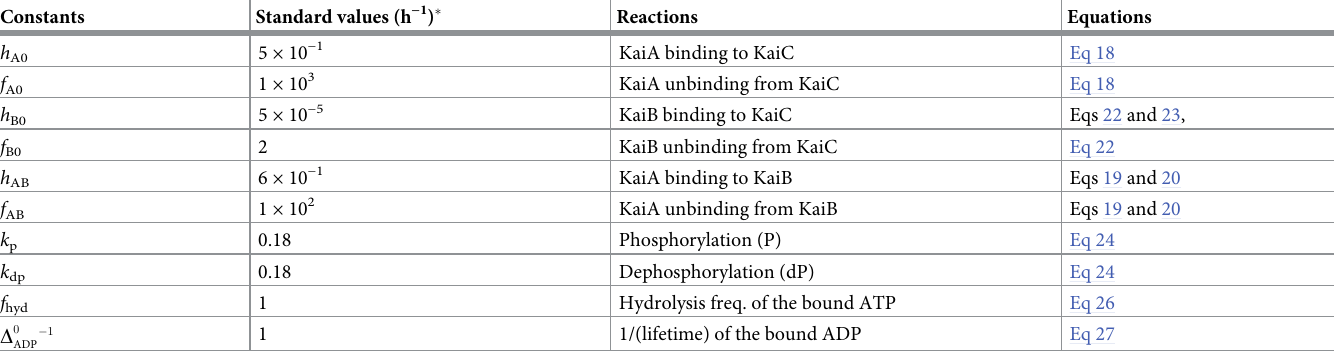
Table 2. Rate constants in the model.